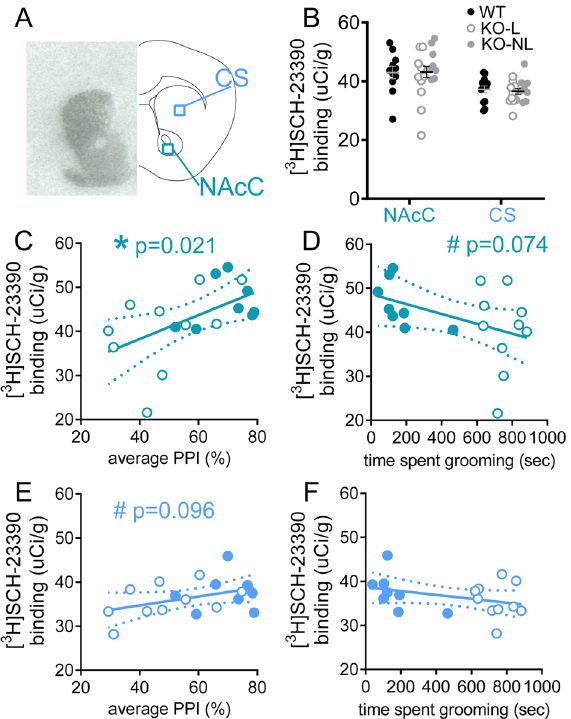
Figure 3. Reduced dopamine D1 receptor density in NAcC is associated with severity of disruption of PPI in Sapap3-KO mice. ( A ) Autoradiography was performed in striatal tissue to quantify density of D1 receptors in CS and NAcC using [ 3 H]-SCH-23390. Representative autoradiograph for total binding is shown (left) and schematic of coronal brain section (right). ( B ) D1 density was unchanged in Sapap3-KOs. In Sapap3- KOs, reduced D1 in NAcC was significantly correlated with reduced PPI ( C ) and showed a trend association with severity of compulsive grooming ( D ). D1 density in CS showed a trend correlation with PPI ( E ) and no association with compulsive grooming in Sapap3-KOs ( F ). * indicates significant correlation, # indicates trend correlation (0.05 < p < 0.10). In panels ( B – F ), unfilled KO symbol indicates KO-L, filled KO symbol indicates KO-NL. n = 13 WT, 18 KO. PPI prepulse inhibition, CS central striatum, NAcC Nucleus accumbens core, KO Sapap3 knockout, KO-L KOs with lesions, KO-NL KOs without lesions, WT